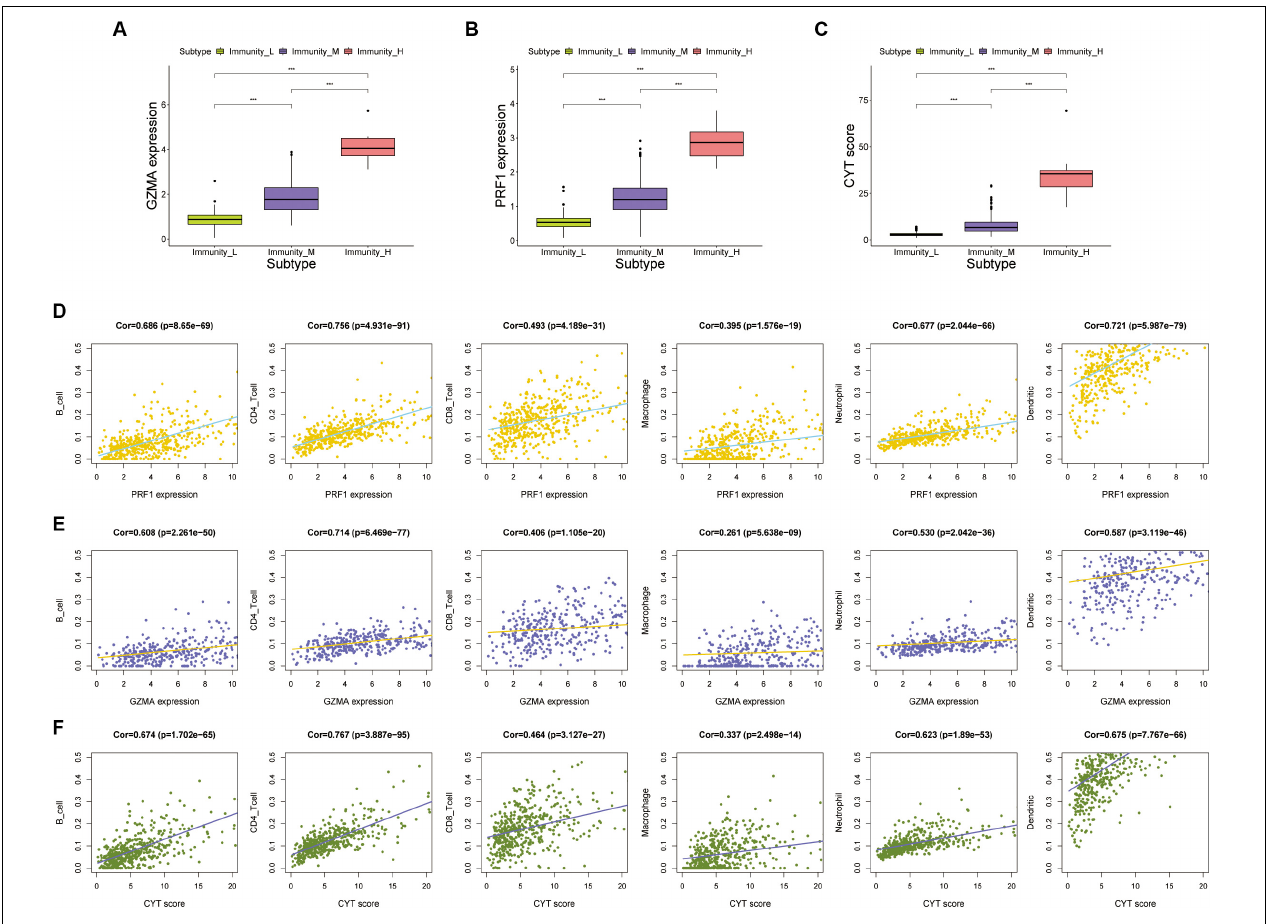
FIGURE 4 | (A–C) The expression of GZMA, PRF1, and CYT in high, medium, and low immune groups ( p value, *** < 0.001). (D,E) There was a significant correlation between the expression of PRF1 and GZMA and immune cells, including B cells, CD4 + T cells, CD8 + T cells, Macrophages, Neutrophils, and Dendritic cells. (F) There was a significant correlation between the expression of CYT score and immune cells, including B cells, CD4 + T cells, CD8 + T cells, Macrophages, Neutrophils, and Dendritic